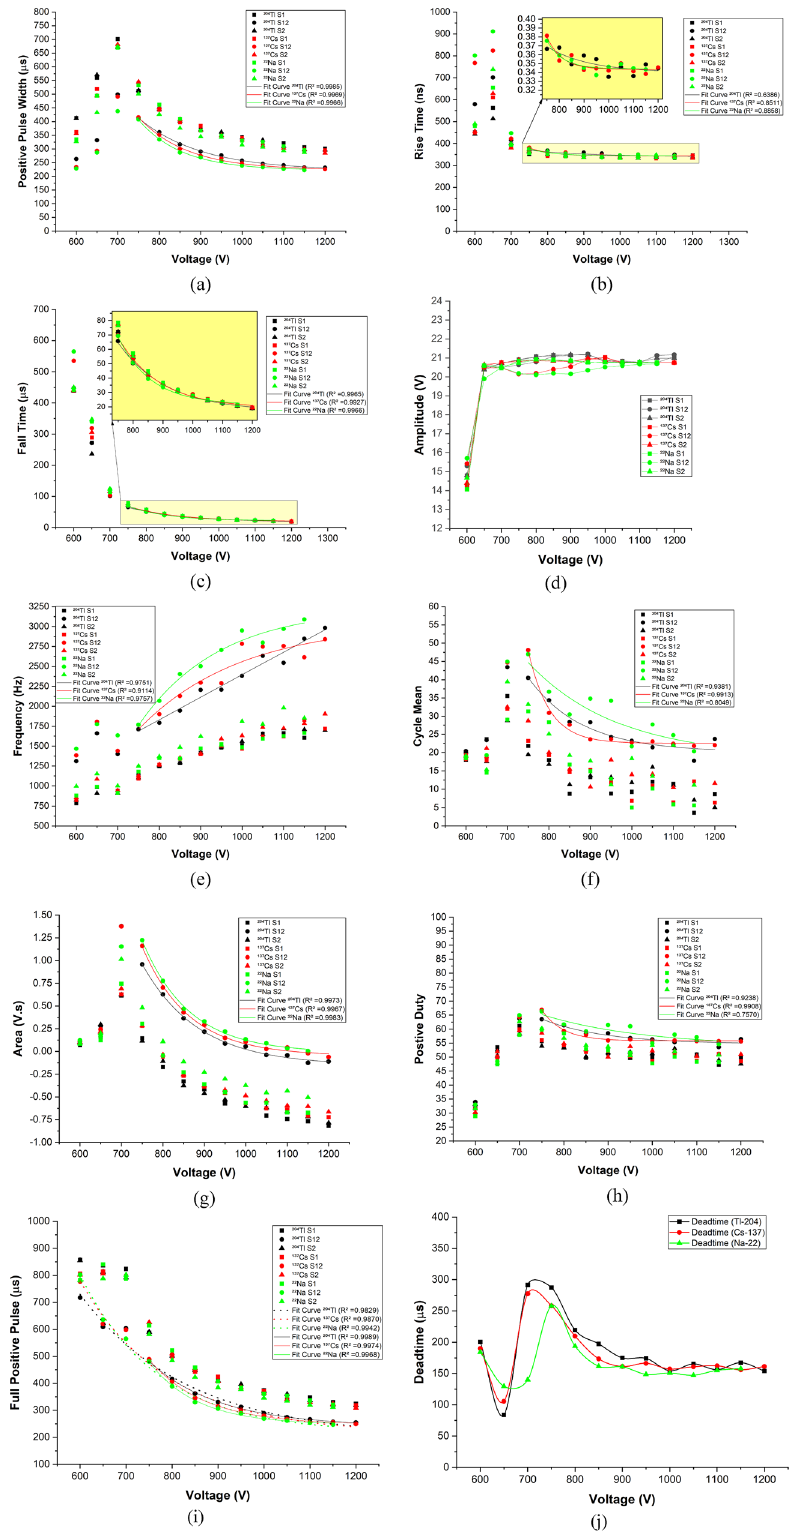
Figure 3. Different parameters with respect to applied high voltage for pulse shape analysis. (OriginPro 2020b, https ://www.origi nlab.com/2020b Annou nceme